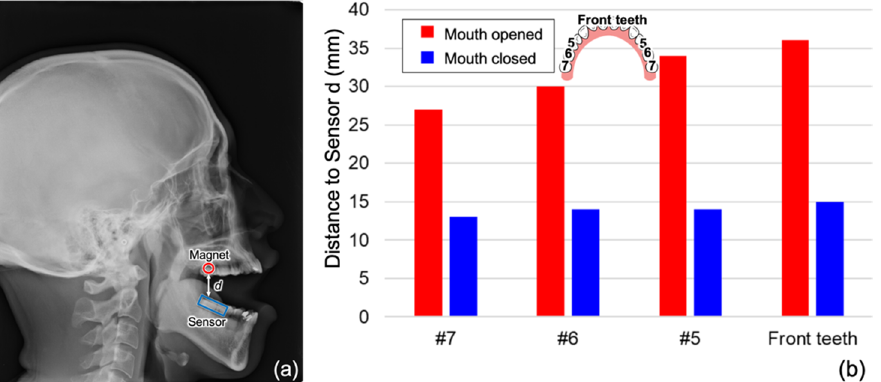
Figure 14. Distance between the magnet and magnetic sensor in each tooth, measured via cephalo- metric images. ( a ) The cephalogram. ( b ) The distance between the magnet and magnetic sensor varies with different tooth positions.